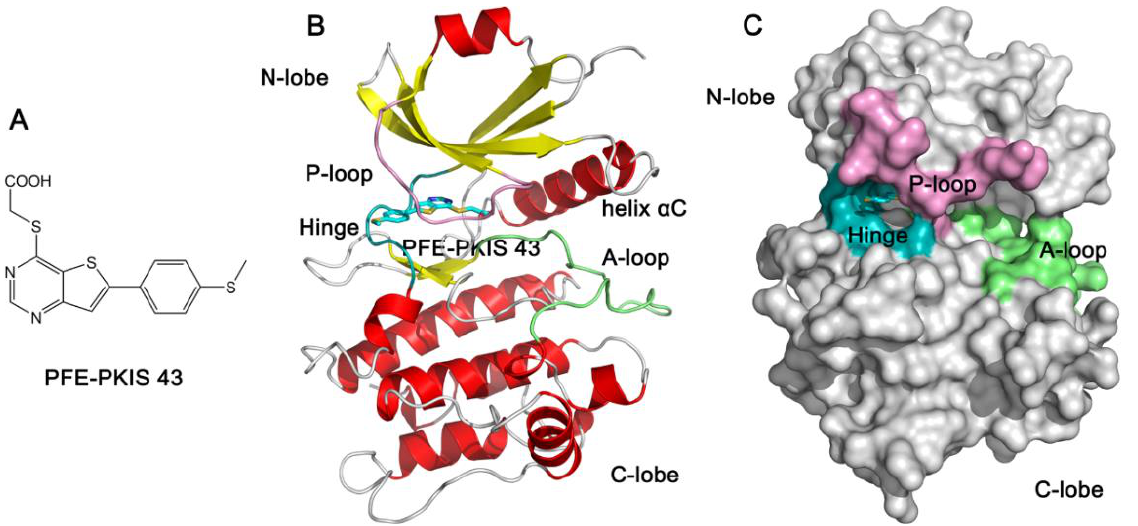
Figure 1. ( A ) Chemical structure of PFE-PKIS-43. Cartoon ( B ) and surface ( C ) representations of STK17B − PFE-PKIS-43 structural complex (PDB ID: 6Y6F). The phosphate-binding loop (P-loop), the hinge, and the activation loop (A-loop) are colored by pink, cyan, and lime, respectively.